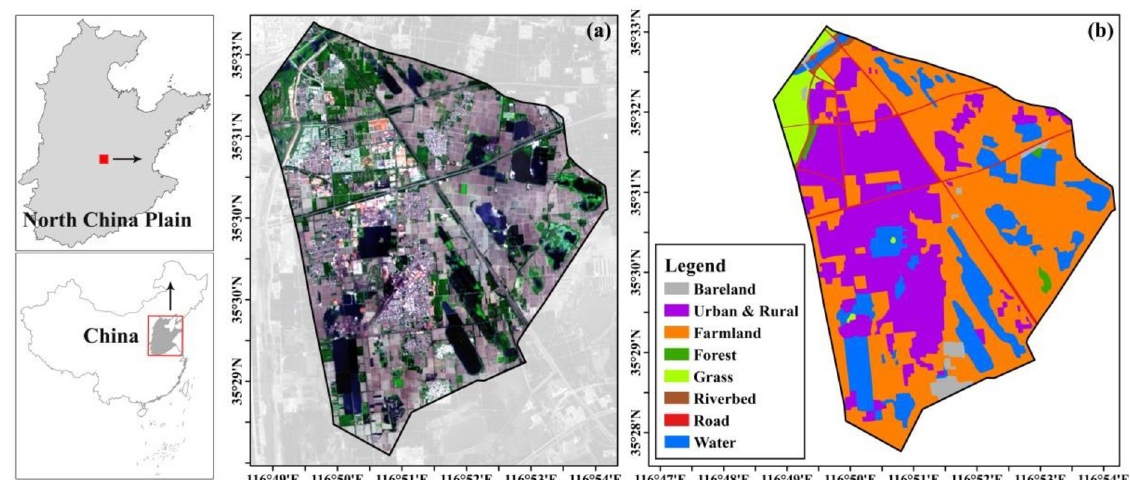
Fig 1. Location and land use map of the study area. (a): Location of the study area, the black line represents the boundary of the coal mining area on a Landsat-8 OLI image (the false color composition) obtained from the Earth Resources Observatory and Science (EROS) Center (http://eros.usgs.gov) in June 2017. (b): Land use map of the study area. The land uses were interpreted visually based on the Landsat-8 OLI image of June 2017and Google Earth 1 high-resolution image.